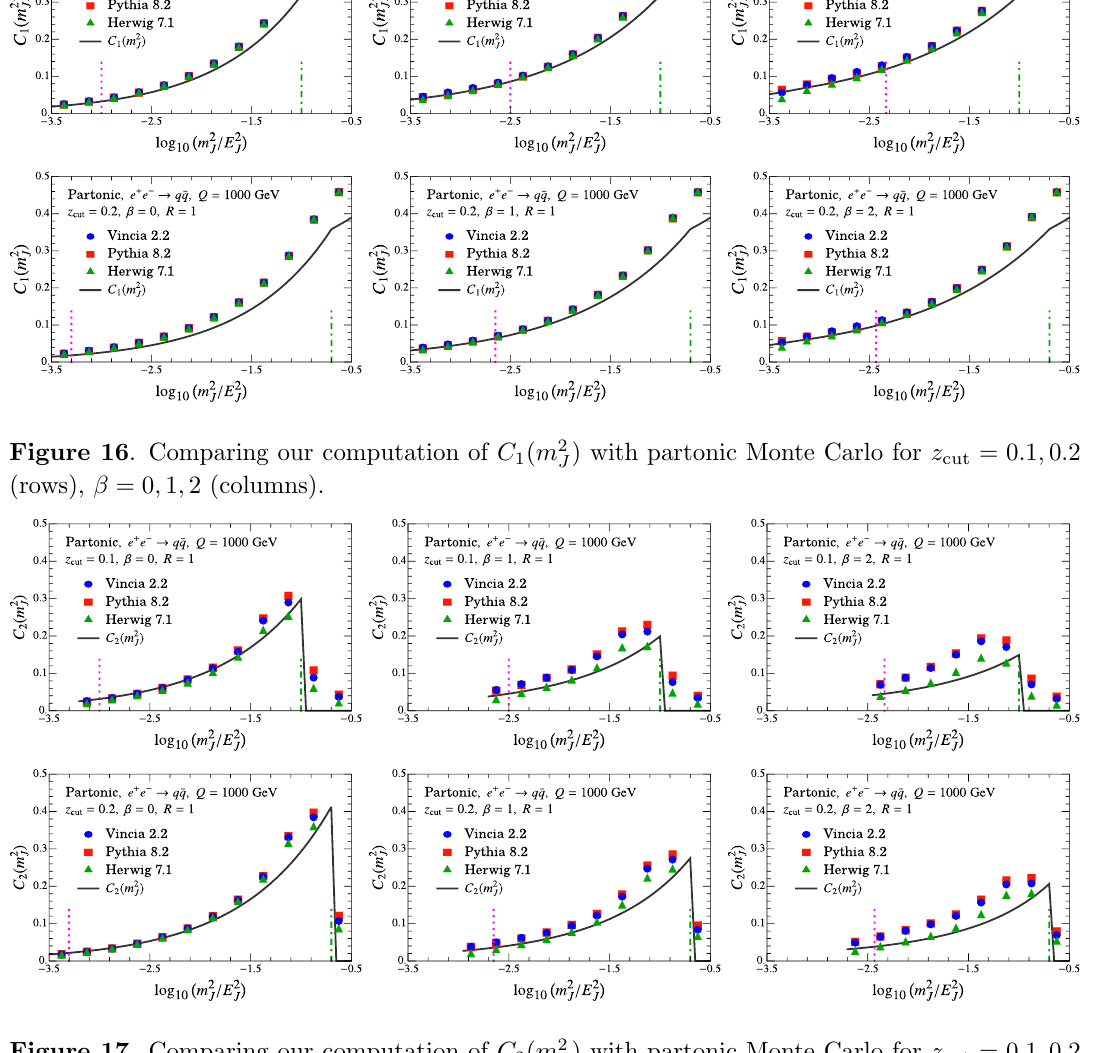
Figure 17 . Comparing our computation of C 2 ( m 2 (rows), (cid:12) = 0 ; 1 ; 2